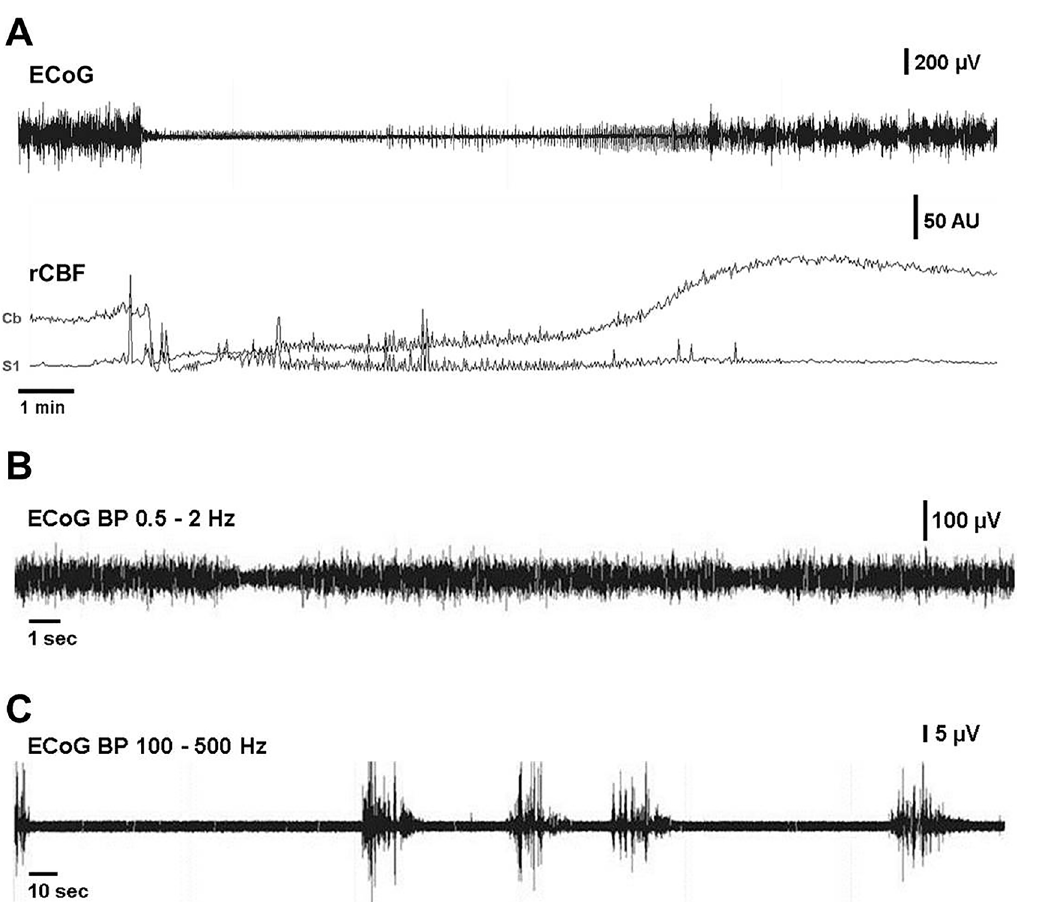
Fig. 5. Exemplary ECoGs during acute SAH. A: Induction of SAH causing immediate severe perfusion impairment corresponds to complete cessation of ECoG signal in some animals lasting several minutes with activity returning in burst suppression patterns. Interburst intervals became continuously shorter until pre-injection levels of total power were reached. B: Bandpass (0.5–2 Hz) filtered ECoG. Recurrent short episodes of depression, potentially corresponding to cortical spreading depression were recorded in the low-frequency range in SAH (n 5 3) but not in either control group. C: Bandpass (100– 500 Hz) filtered ECoG. In SAH animals, short bursts in the ultra-high frequency spectrum occurred about 24 hours after